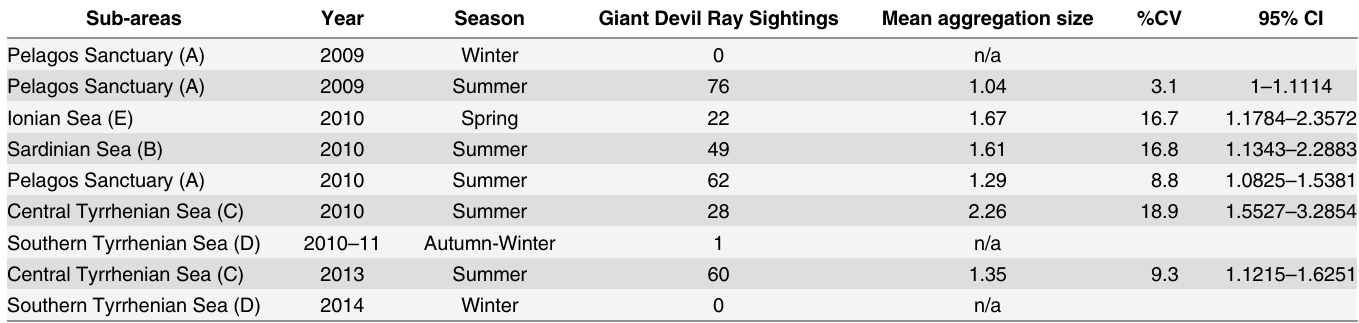
Table 2. Total sightings (on track and off track) in the different sub-areas (capital letters refer to sub-area locations in Fig 1), and mean aggregation sizes (CV = coefficient of variation; CI = confidence interval; n/a = not applicable).